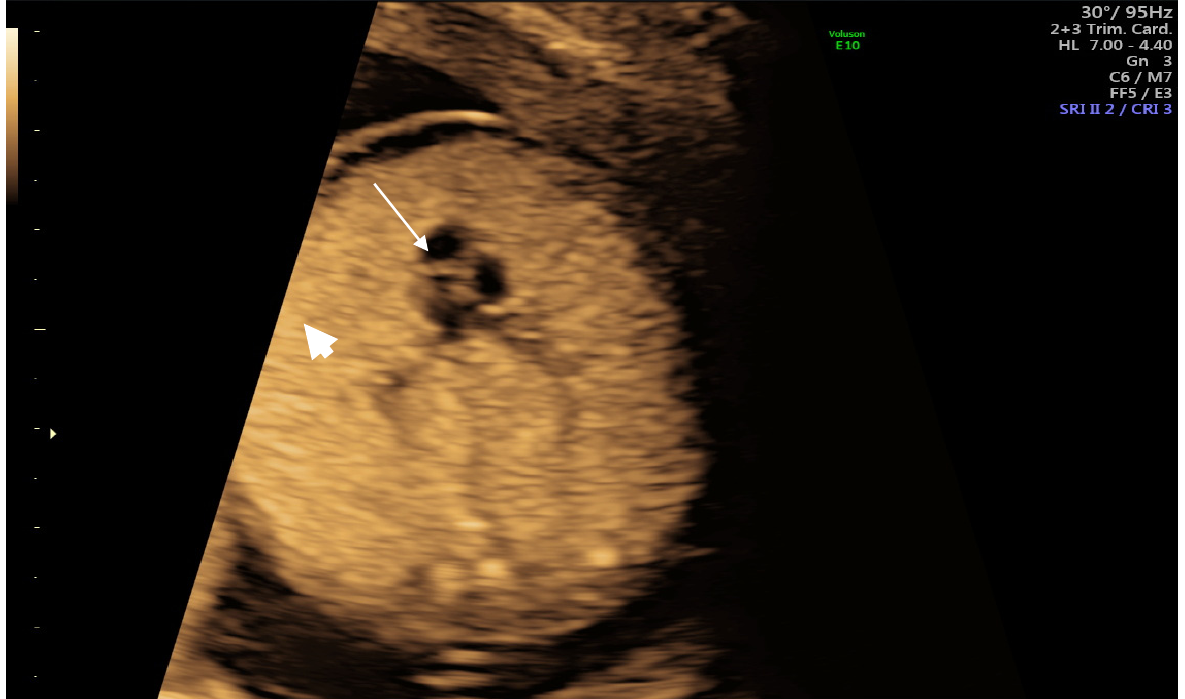
Figure 1. Heart (arrow) and hyperechogenic lungs (arrowhead) on scan. Permission for autopsy was obtained from the parents, and the product of conception with umbilical cord and placenta was sent to the Department of Pathology for histopatho- logical examination. circumference: 13 cm, thoracic circumference: 10 cm, abdominal circumference: 9